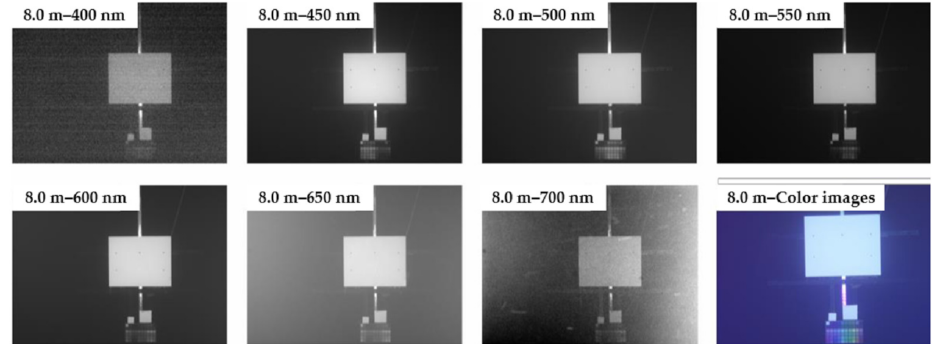
Figure 9. Partial spectral image of target whiteboard at 8 m distance, illuminated by underwater LED light